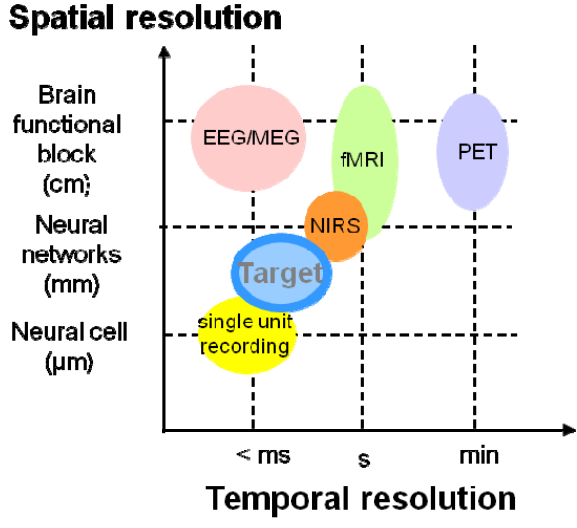
Figure 14. Spatio-temporal map of measurement technologies for neural activity (adapted from